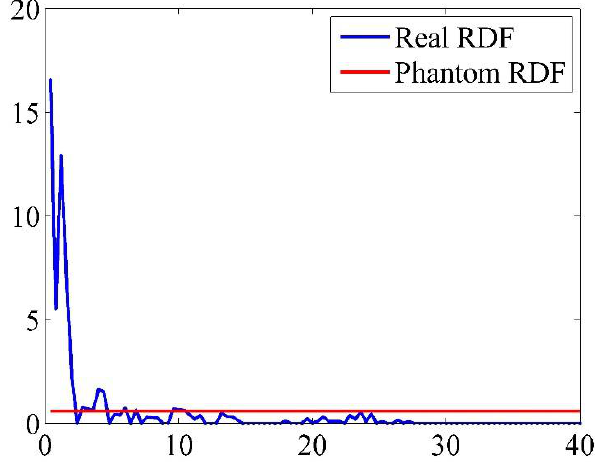
Figure 4. An example radial distribution graph of ship velocity.